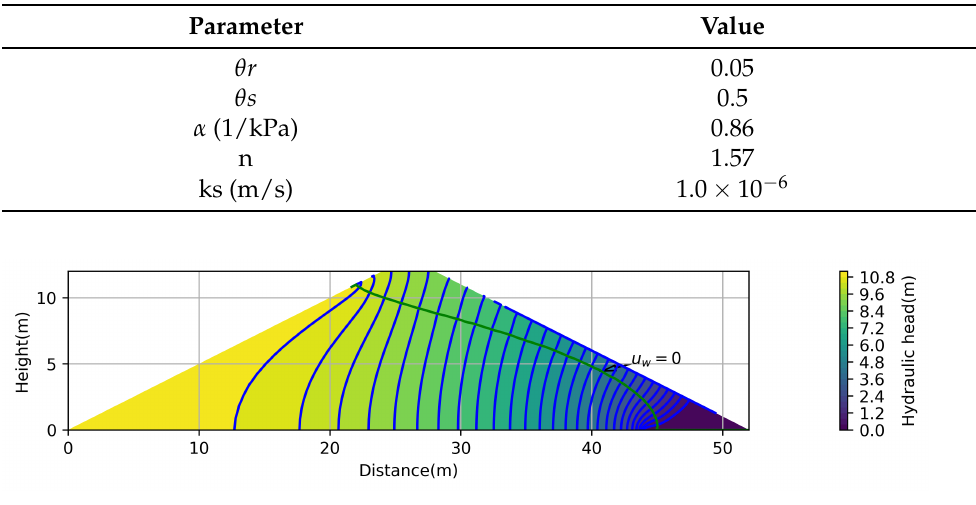
Figure 6. FEM solution in the refined